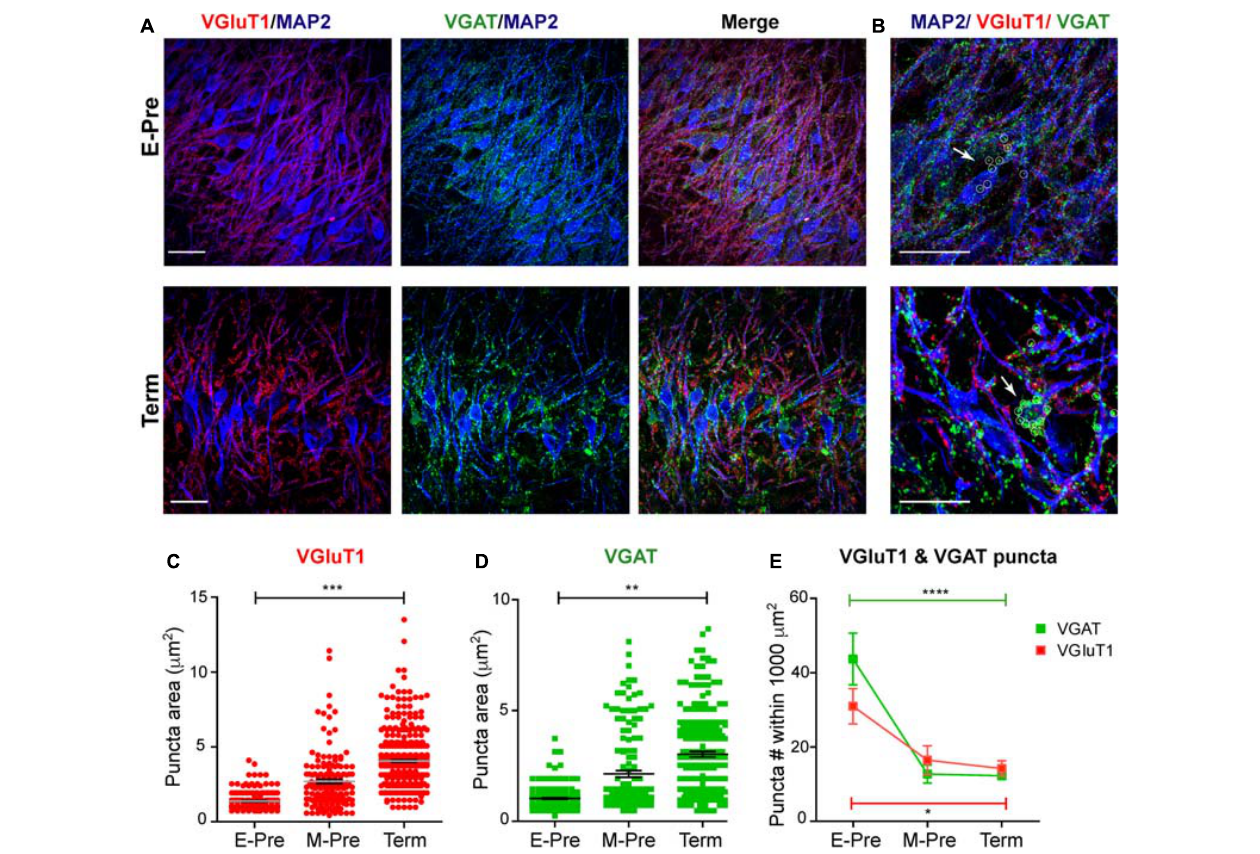
FIGURE 3 | Synaptic inputs on MSO neurons during gestational development of baboon neonates. (A) MSO nuclei were immunostained with MAP2 (blue), VGluT1 (red), and VGAT (green) in the auditory brainstem at E-Pre (top) and Term (bottom). Scale = 50 µ m. (B) Magnified image of MSO neurons. White arrows and small circles indicate VGAT signals (green) on MSO somata. Scale = 50 µ m. (C,D) Changes in the puncta area for VGluT1 (C) and VGAT (D) from E-Pre, M-Pre, and Term neonates. (E) Numbers of VGluT1 and VGAT puncta per a defined area (1000 µ m 2 ) in the MSO. Data were shown as mean ± s.e.m. * < 0.05, ** < 0.01, *** < 0.001, and **** < 0.0001, a nested one-way